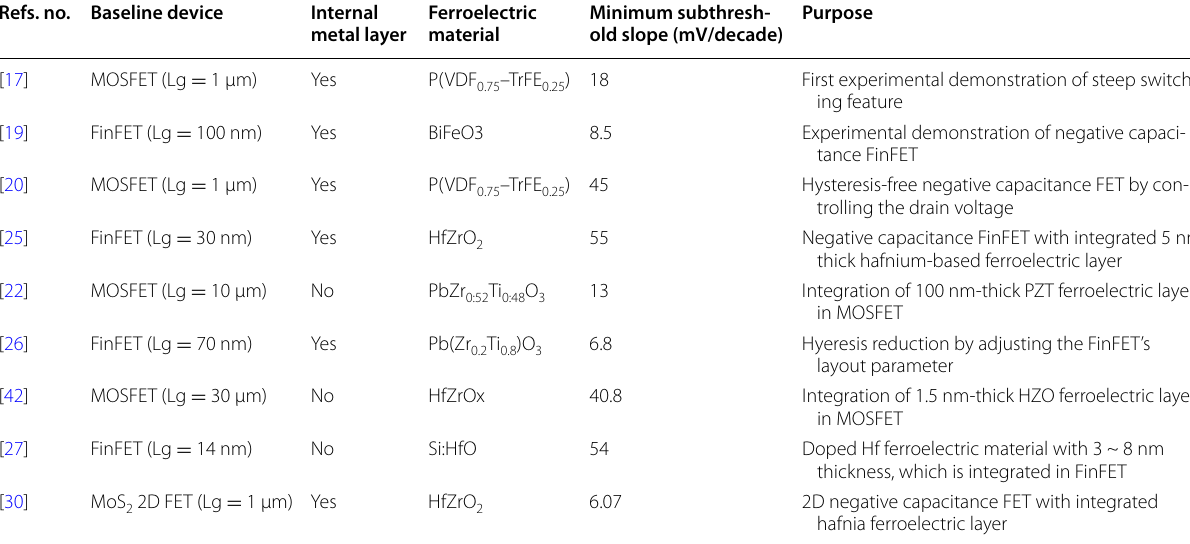
Table 1 Overview of experimental results of negative capacitance field effect transistors Refs. no. Baseline